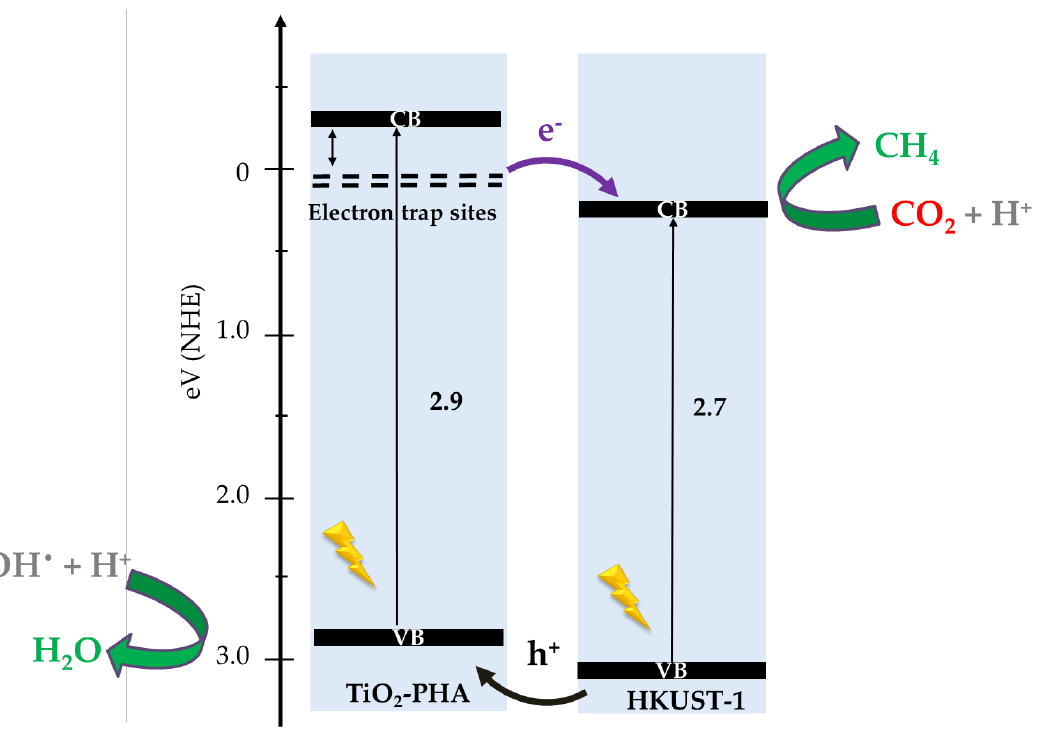
Figure 9. Representative image of the energy levels of TiO 2 -PHA and HKUST-1 at the hybrid interface in TiO 2 /HKUST-1 with proposed photocatalytic CO 2 photoreduction pathway under sunlight irradiation.